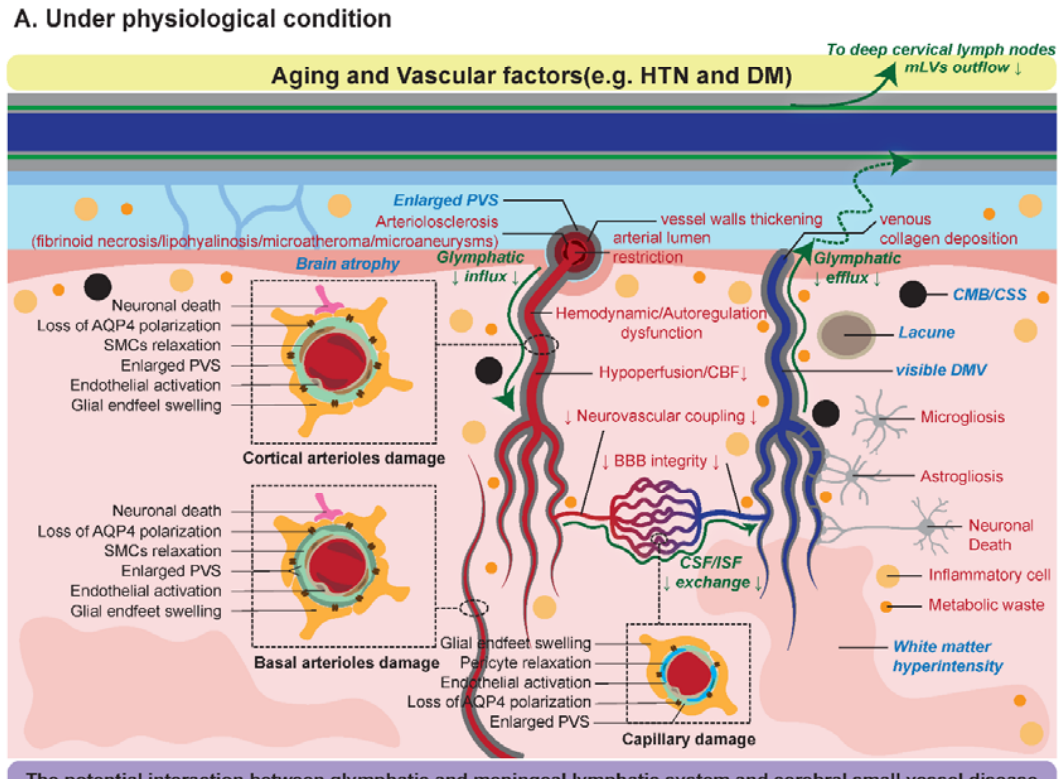
Figure 4. The possible hypothesis of potential interaction between CSVD and glymphatic and meningeal lymphatic system. In sporadic CSVD, normal aging may be an initial event in CSVD patho ‐